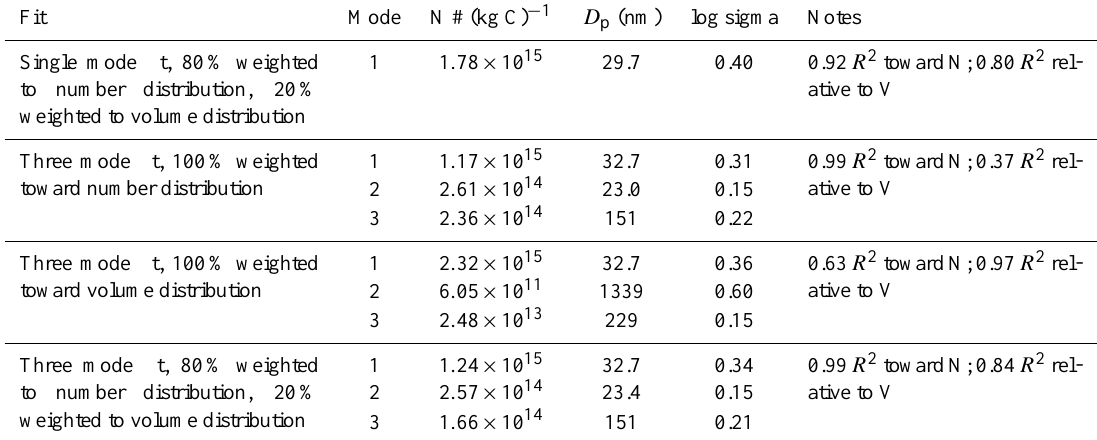
Table 4. Parameters for lognormal modal fits of the emission